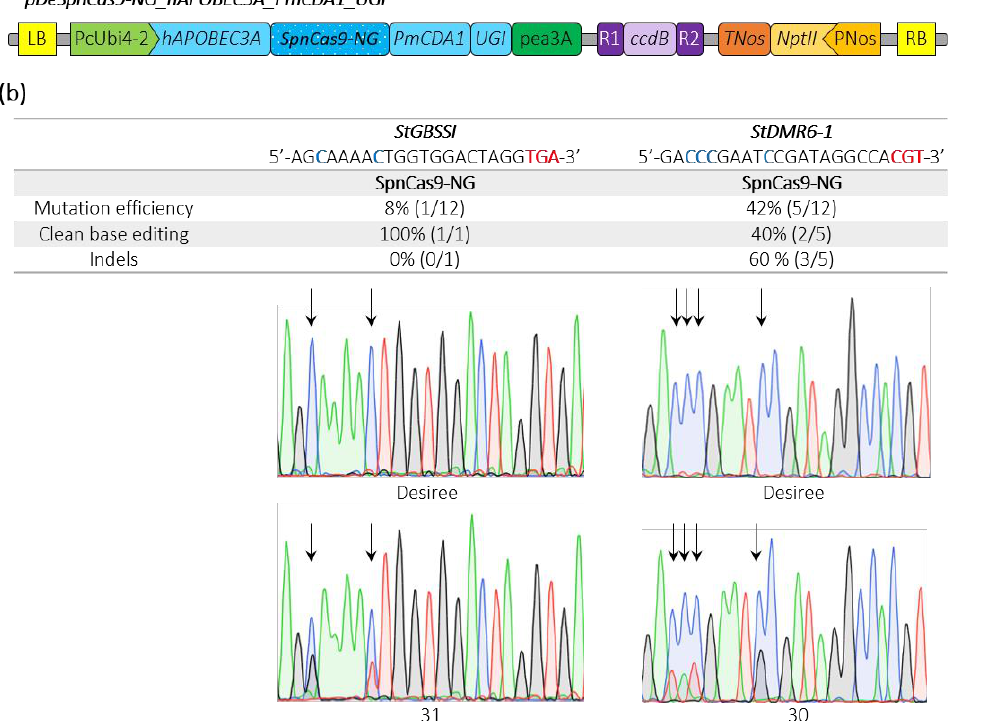
Figure 4. Schematic representation of a SpnCas9-NG double cytosine base editor binary plasmid and editing efficiencies in potato. ( a ) The double cytosine base editor construct used for Agrobacterium - mediated transformation of potato (Desiree) is schematically represented. ( b ) Edition efficiency represents the percentage of mutated plants among the transgenic plants. The modified cytosines observed in the edited plants are indicated in bold blue. Clean base editing refers to plants harboring substitution(s) without any detectable indels on Sanger chromatograms. The StGBSSI and StDMR6-1 Sanger chromatograms for the control potato variety (Desiree) and two potato mutants harboring clean base editing with expanding editing window are shown. The PAM sequence is depicted in bold red. Black arrows highlight the position of edited cytosines. A, T, C and G bases are represented in green, red, blue and black, respectively.